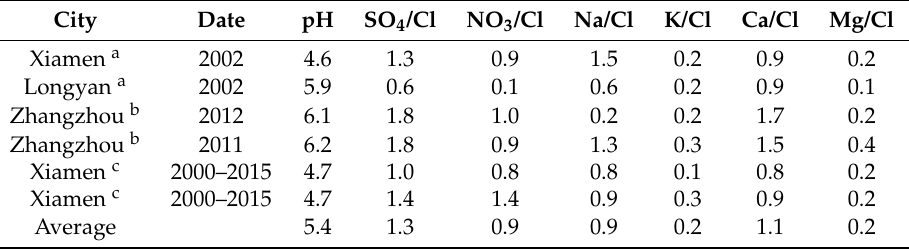
Table 1. Cl-normalized molar ratios in rainwater within the Jiulongjiang River basin (JRB).